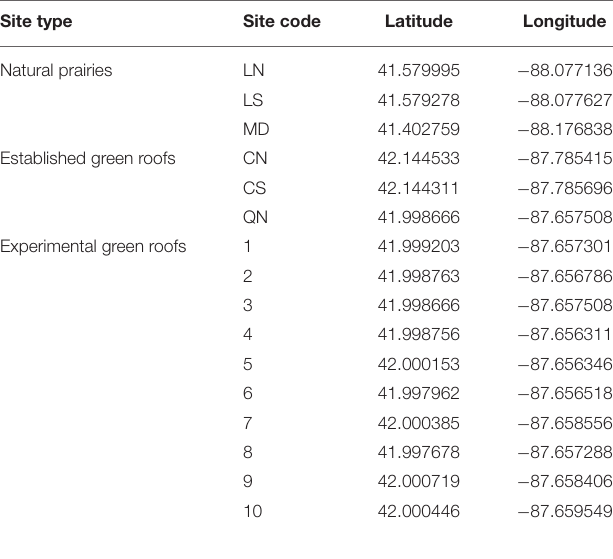
TABLE 1 | Geographic coordinates for populations used in this